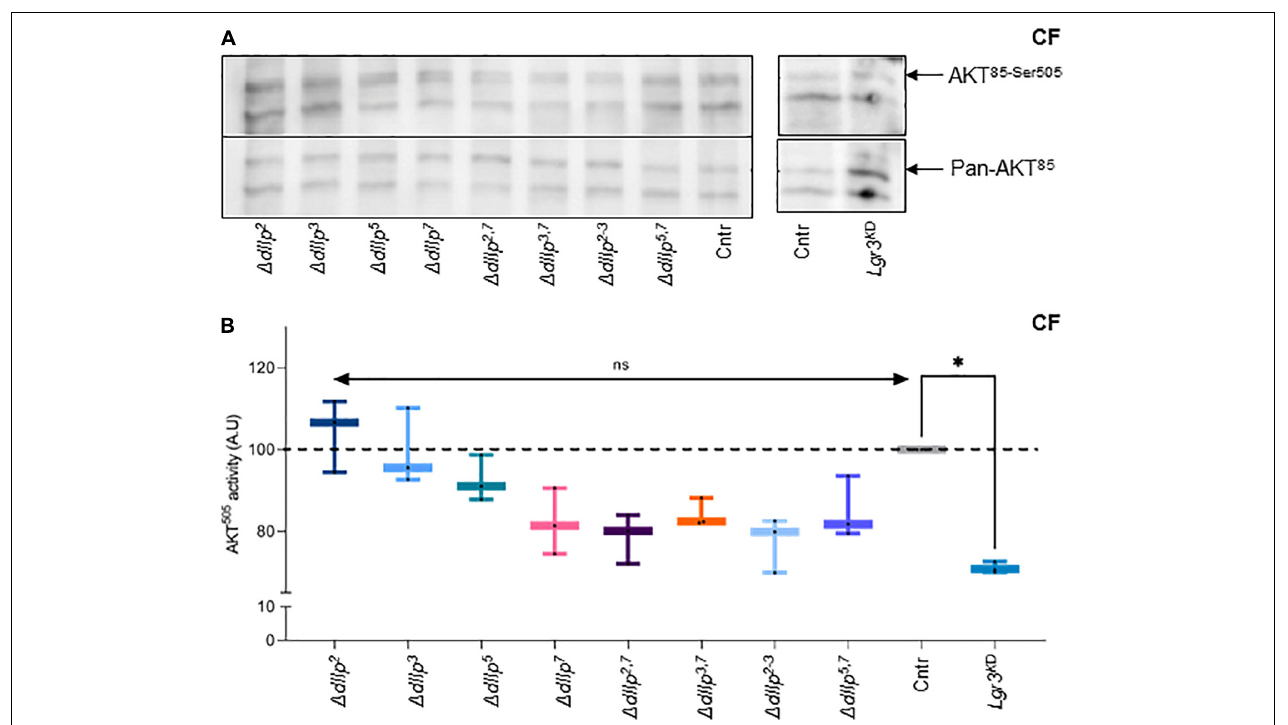
FIGURE 4 | DIlp7 regulates systemic Insulin signaling in adult fed on yeast-free plant diet. (A,B) Adult head samples were probed with antibodies for phosphorylated AKT 85 − Ser 505 and total AKT amounts (pan-AKT). Shown are western blot photographs from genetic control ( mCherry:FOXO , Cntr) and different dIlp mutants kept on corn food (CF) at 20 ◦ C. AKT 85 − Ser 505 / pan-AKT signal ratios were normalized to controls and plotted as AKT 505 activity (B) . Genetic controls ( mCherry:FOXO , Cntr), different dIlp mutants and flies with Lgr3 knocked-down in IPCs ( Lgr3 KD ) were measured and plotted on box-plots. The activity of each genotype was normalized to the control ( Cntr , gray, median = 100%). Significances not shown if the n is not enough significant ( n < 3). Statistics, Kruskal-Wallis test, p > 0.05 ns ; p = 0.0145 ∗ . For crude data, see Supporting informations_Raw data_Main figures/ Supplementary Figure 4B .